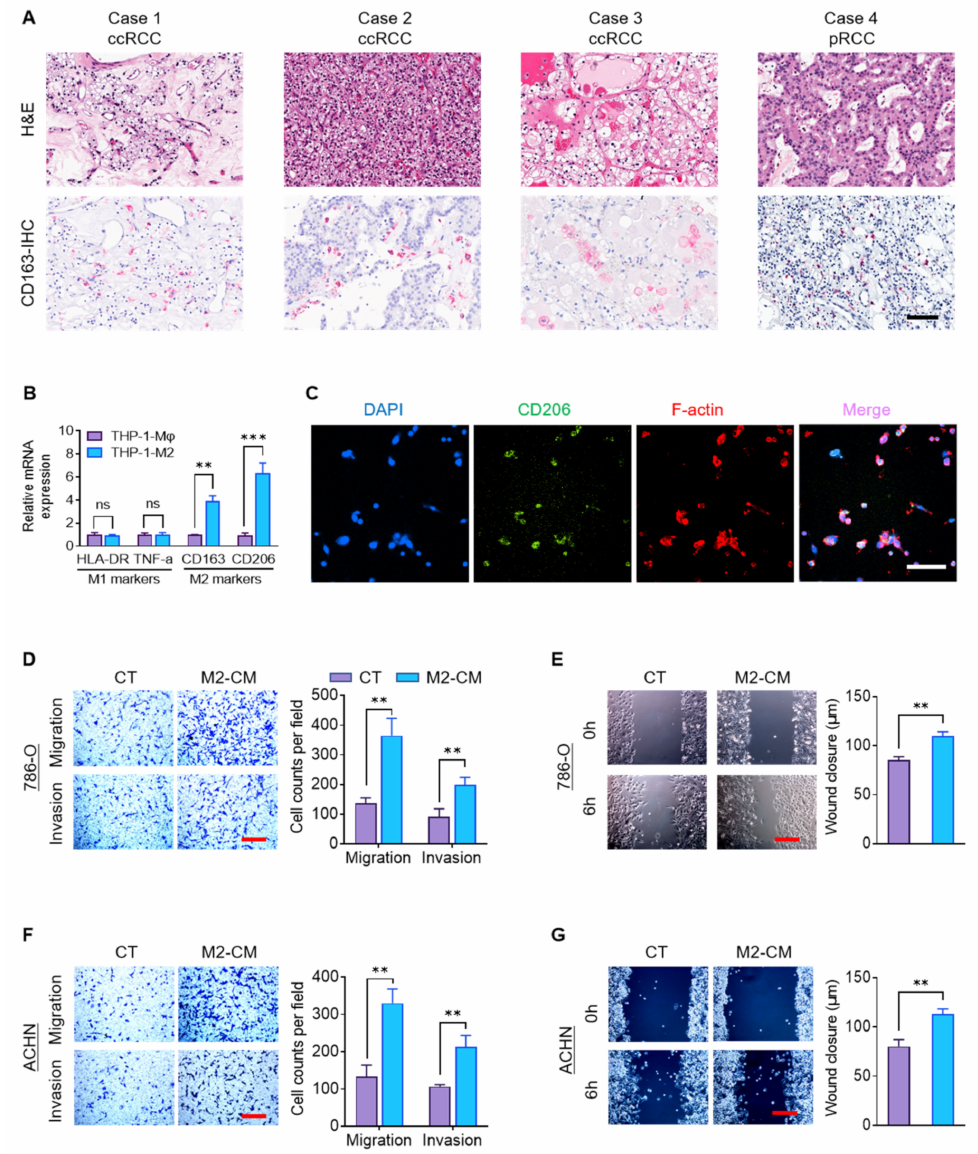
Figure 1. M2 macrophages promote RCC migration and invasion. ( A ) H&E and CD163 IHC stain- ing (red) of four representative clinical RCC samples. Scale bar: 50 µ m. ( B ) Macrophage marker mRNA expression was assayed in THP-1-M ϕ and THP-1-M2 cells by RT-qPCR. ( C ) IF staining of nuclei (DAPI), CD206, and F-actin in THP-1-M2 cells. Scale bar: 50 µ m. ( D – G ) Cellular migration and invasion of 786-O and ACHN cells treated with M2-CM or control media were assessed by transwell and wound-healing assays. Scale bar: 100 µ m. ** p < 0.01, *** p < 0.001, ns: not significant. pRCC: papillary renal cell carcinoma; CT: control; RT-qPCR: reverse transcription-quantitative